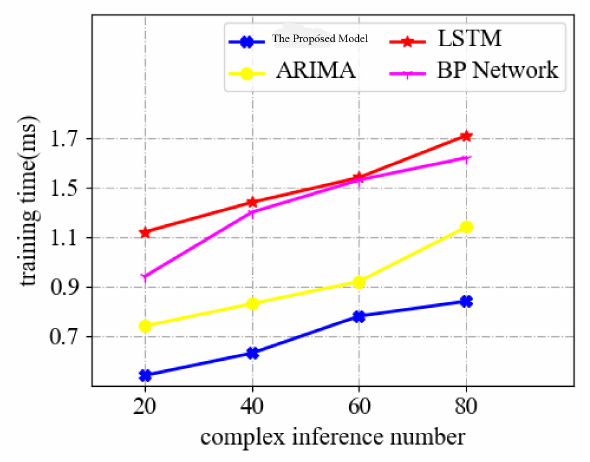
Figure 7. Comparison of the training time in complex datasets.